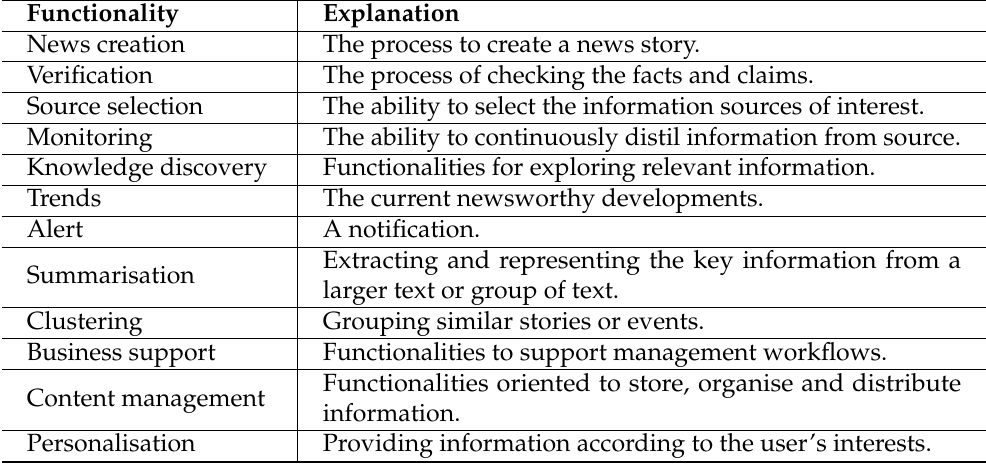
Table 3. Most common type of functionalities and services provided in